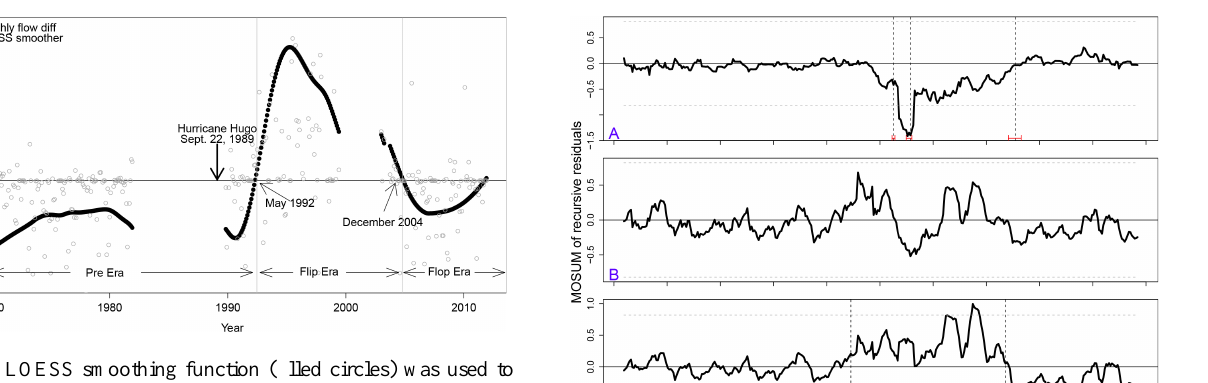
Fig. 3. A LOESS smoothing function (filled circles) was used to discern trends in monthly flow differences (open circles) between watershed 77 and watershed 80. Hurricane Hugo struck the study watersheds in September 1989. The LOESS smoothing function crosses the x axis at two points that mark the transition points be- tween three eras: pre, flip and flop. Flow data were not recorded in the periods 1982–1989 and 1999–2002 due to discontinuation of streamflow monitoring for those periods. Points on the zero- difference line represent no-flow conditions in both watersheds, typ- ically in late summer.